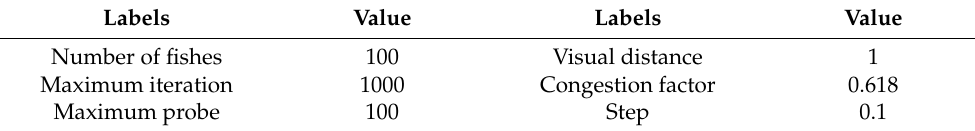
Figure 19. Curves of the cost function value. ( a ) N = 2, ( b ) N = 4, ( c ) N = 6, ( d ) N = 8, ( e ) N = 10. Table 4. Parameters for the AFSA.